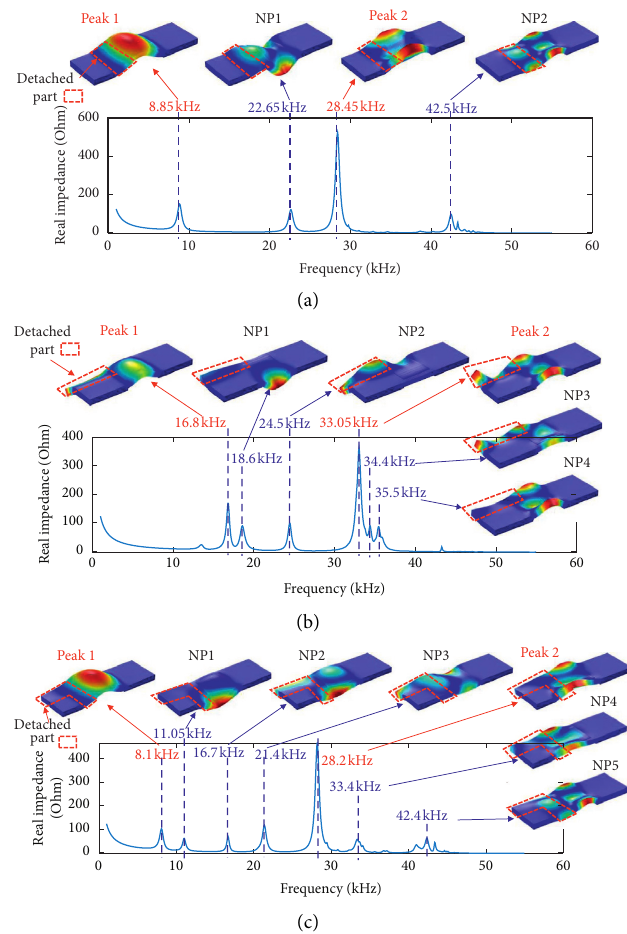
Figure 29: Modal shapes of the impedance peaks for the cases of interface detaching. (a) Case: V2. (b) Case: H2. (c) Case: